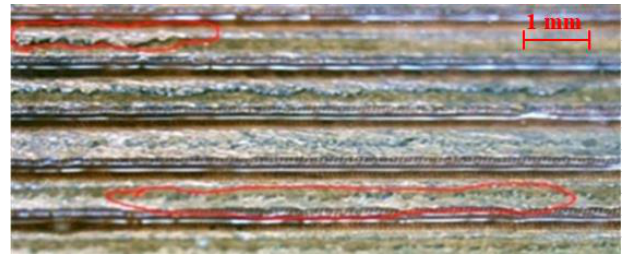
Figure 6. Water condensates on the lug boss between grooves under 8 W.